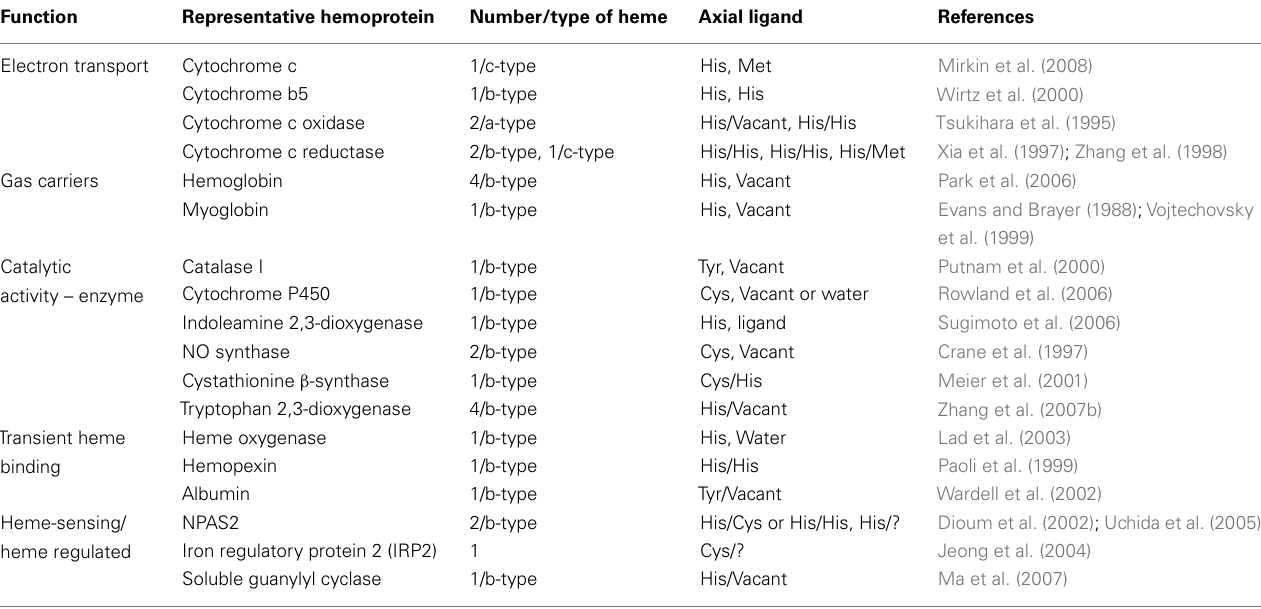
Table 1 | Selected representatives of Mammalian hemoproteins and heme-sensing